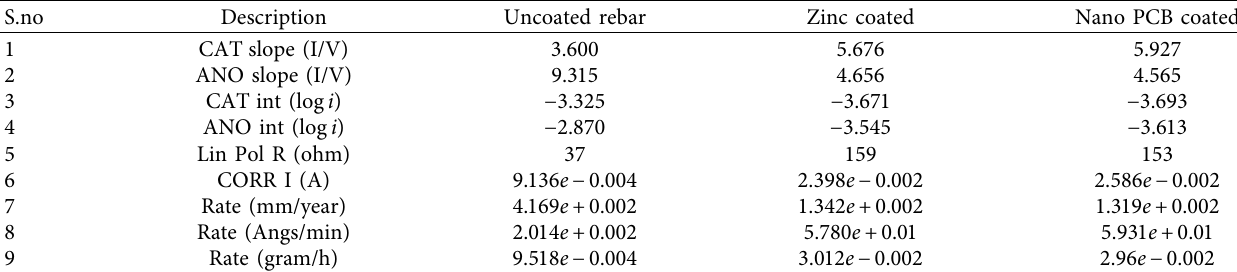
Figure 6: TAFEL plot of the specimens (bare ⟶ uncoated specimen; sample 5 ⟶ with commercial anticorrosive paint; sample 6 ⟶ zinc coated specimen; sample 7 ⟶ nano PCB-coated specimens). Table 3: Comparison of potentiodynamic polarization